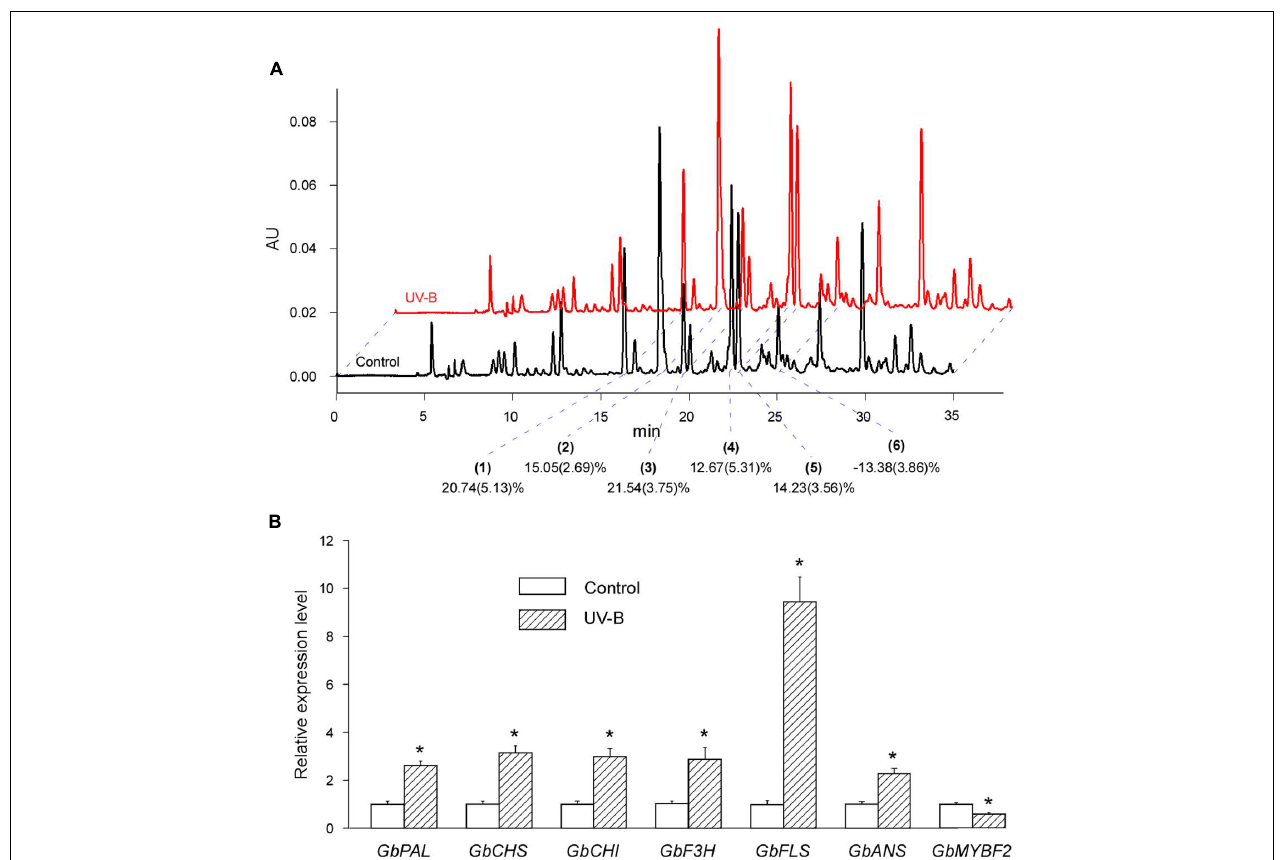
FIGURE 2 | UV-B irradiation induces both the accumulation of flavonoids and the expression of corresponding genes. (A) Typical UV-B treated (red) and control (black) HPLC fingerprints (absorption at the wavelength of 360 nm) of the total extract of cultured post-harvest Ginkgo leaves. The peaks are justified by blue dotted lines. The main peaks (indicated by 1, 2, 3, 4, 5, and 6) are analyzed for changes after various treatments. Changes in relative flavonoid contents are marked and the SD values are in brackets. (B) Relative expression levels of flavonoid biosynthesis related genes induced by UV-B treatment. Asterisks indicate significant